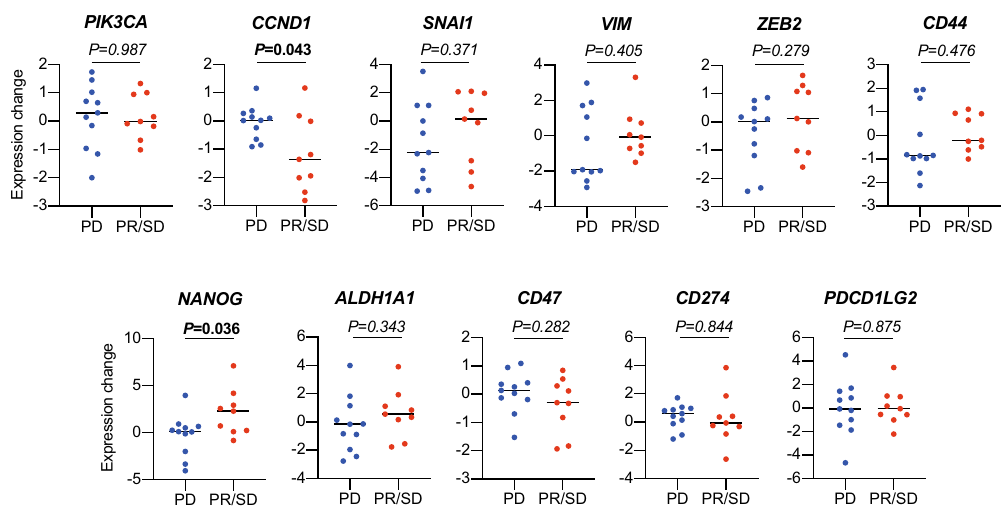
Figure 3. Changes in gene expression in CTCs during nivolumab treatment. The patients with CTCs were divided into two groups according to treatment responses: the disease-controlled group and disease-progressed group. The changes in gene expression in CTCs was compared between the two